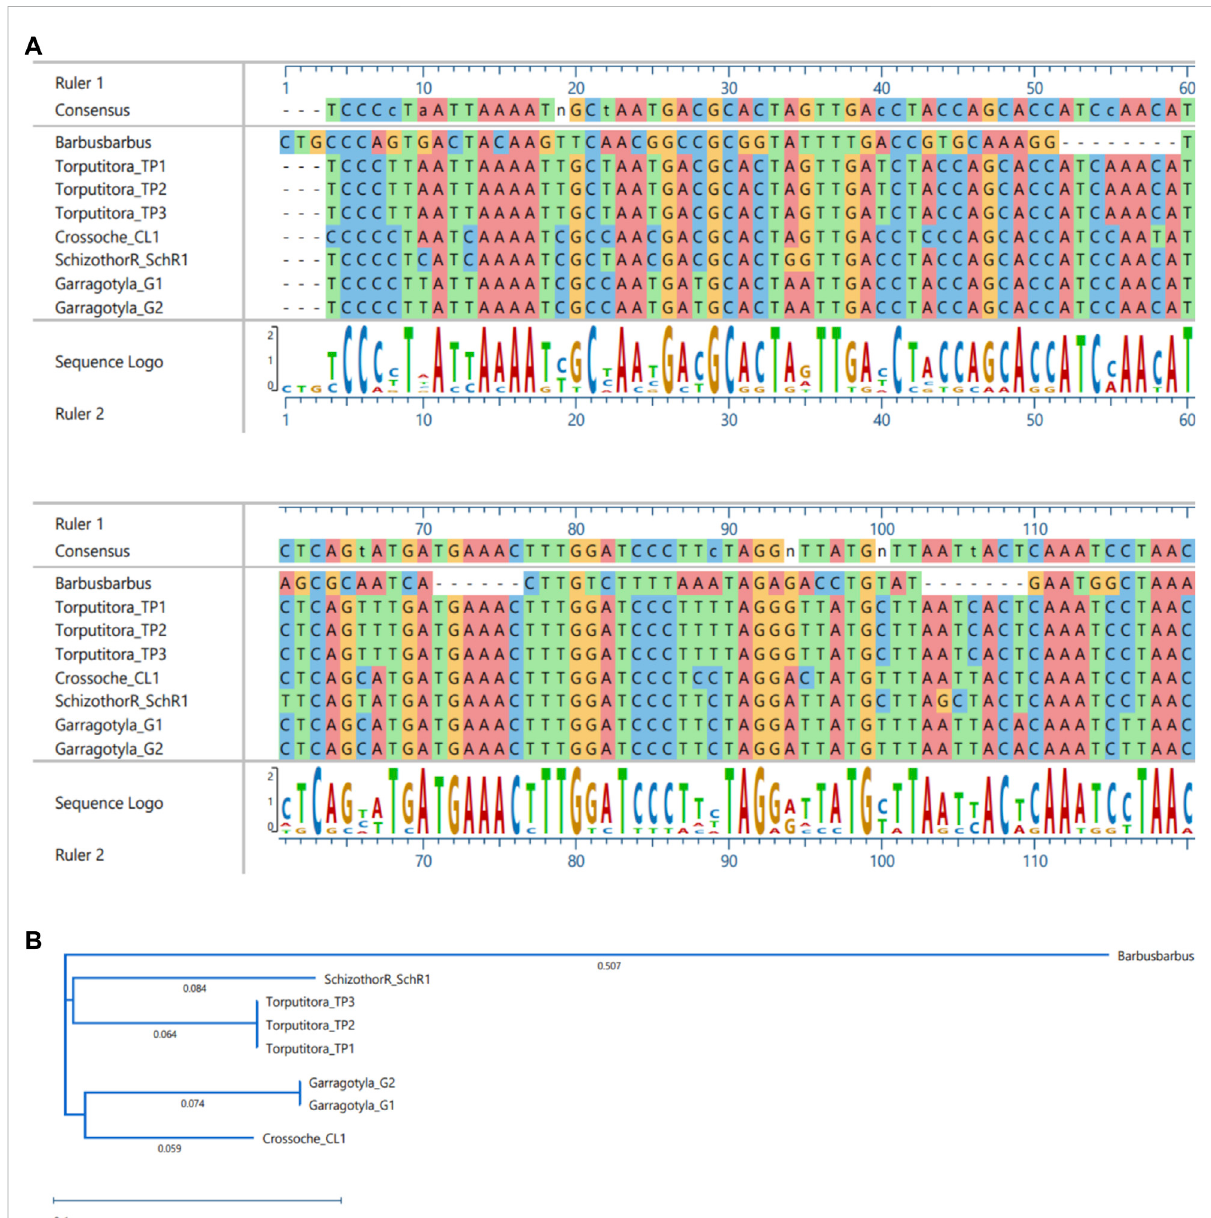
MSA (A) and Phylogenetic Tree (B) ofCYT-B sequences.MSAwasperformedusing MUSCLEProgram and Phylogentic analysis wereperformed using PhyML algorithm (parameters — bootstrap value = 100, tree search = “ Best from NNI and SPR ” , Sarting tree = “ BioNJ, ” equllibrium and site rate variation = “ Optimized ”